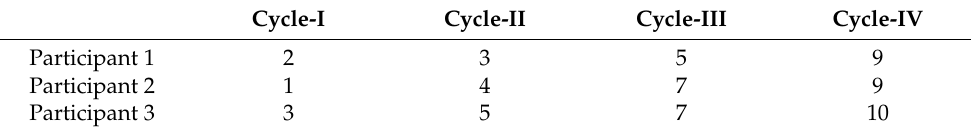
Table 2. Fatigue scores reported after each cycle of activities in Phase I. Cycle-I